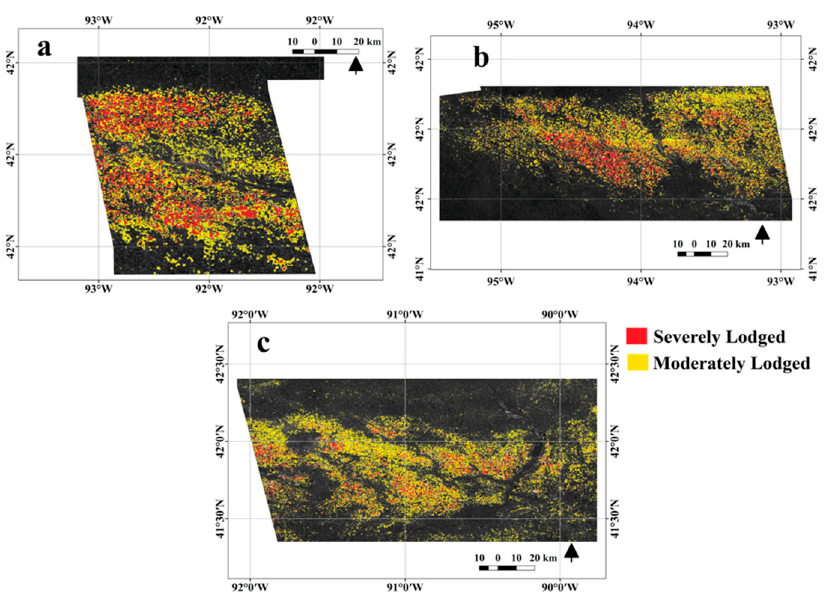
Figure 7. Lodging maps generated between ( a ) 29 July 2020 and 22 August 2020; ( b ) 3 August 2020 and 15 August 2020; ( c ) 4 August 2020 and 16 August 2020.